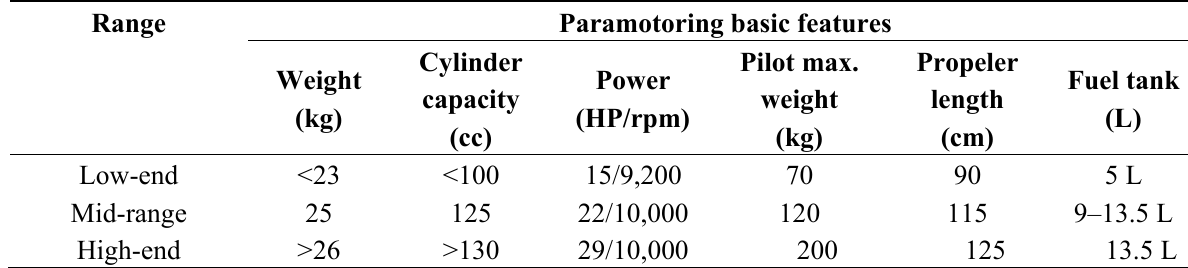
Table 1. Paramotoring classification and basic